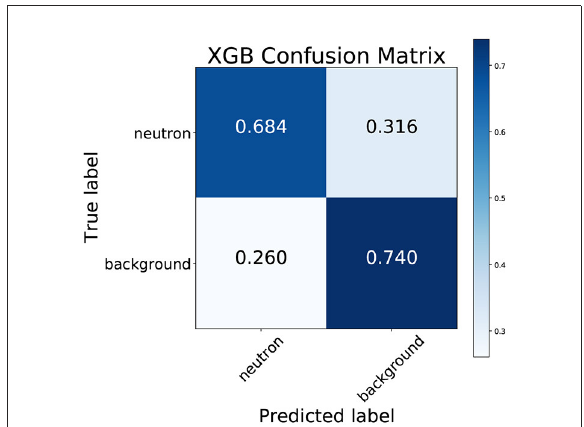
FIGURE3 Confusion matrix for the XGBoost model trained on the dataset of neutron capture and spallation background electron